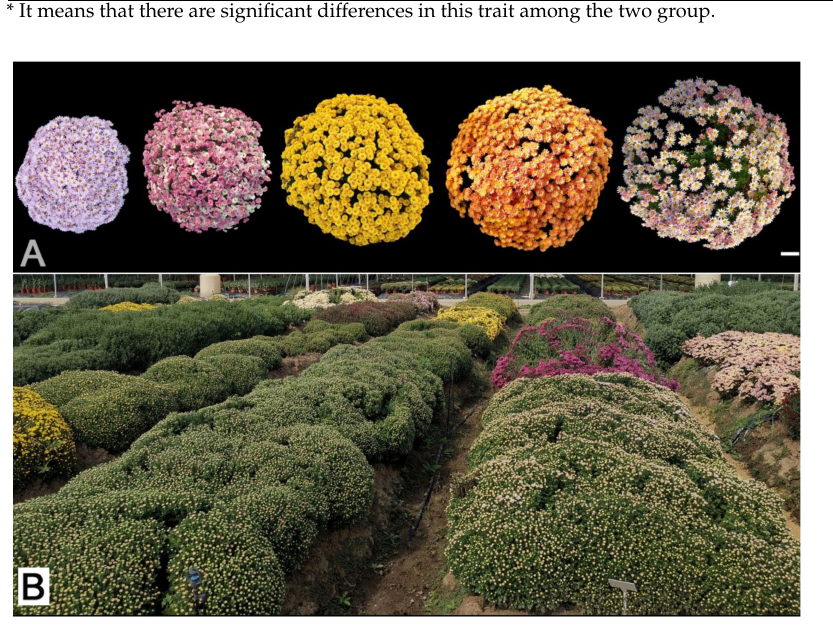
Figure 2. Plant form of F1 generation: ( A ) Plant form of the five offspring with the highest compre- hensive score; ( B ) Plant form of other hybrid offspring in the